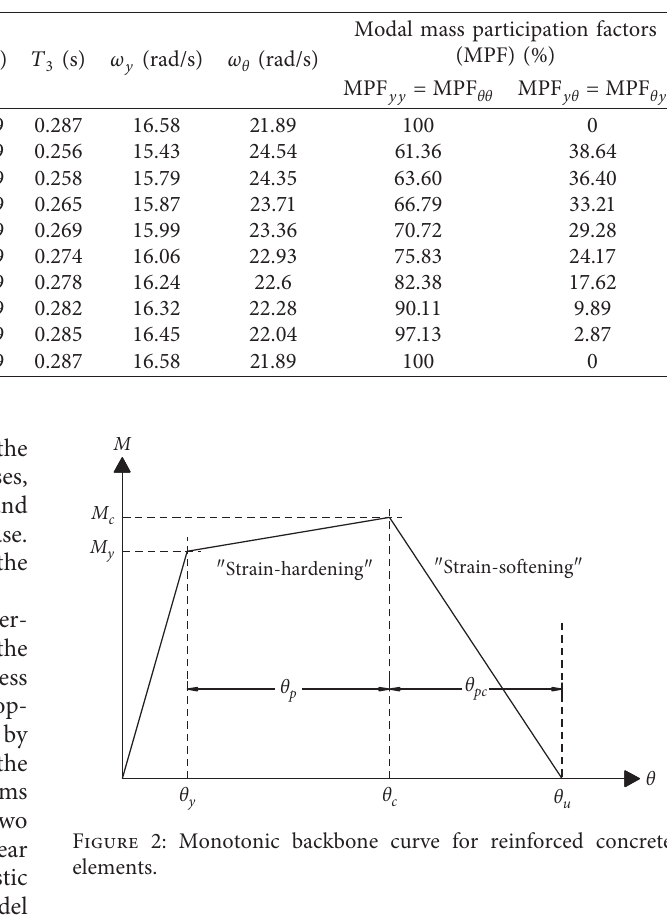
Table 1: General properties of the building models.